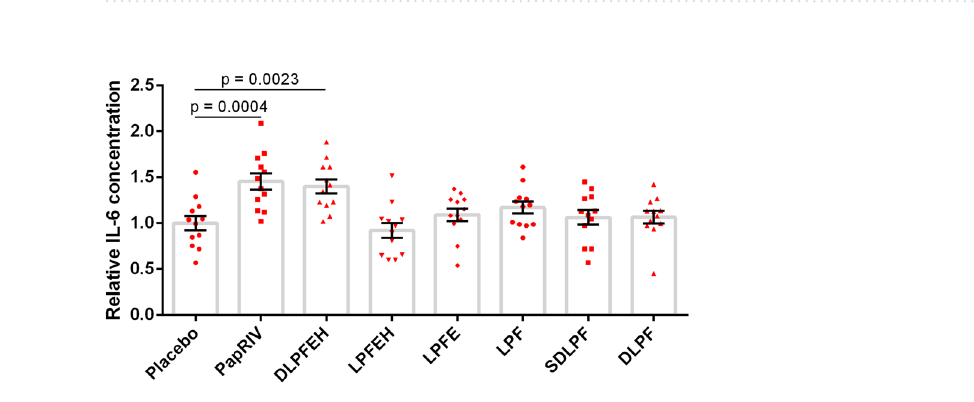
Figure 4. Activating properties of PapRIV metabolites on BV-2 microglia cells (10 µM, n = 12). Mean ± SEM, one-way ANOVA, post-hoc